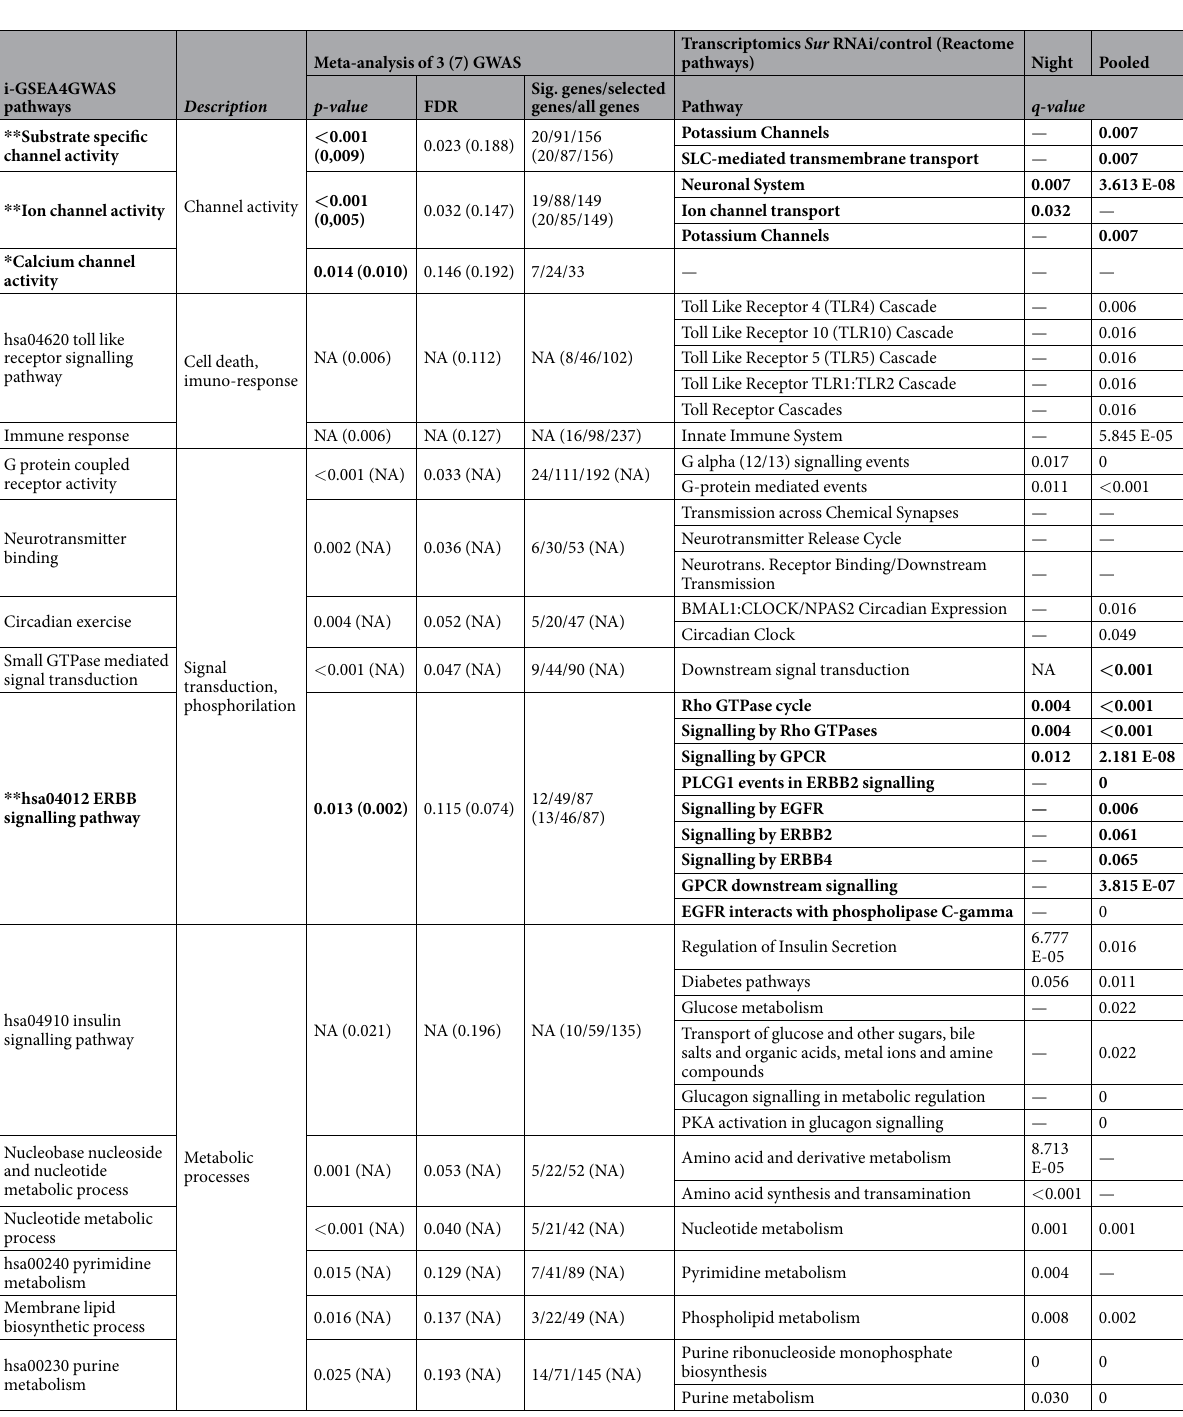
Table 2. Significant pathways in the independent GWAS meta-analyses and in the Drosophila transcriptomics study iGSEA4GWAS detected pathways for the current and published GWAS meta-analyses results can be found at: http://gsea4gwas.psych.ac.cn/getResult.do?result =